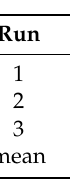
Table 8. OCV of the stack before each constant current run.